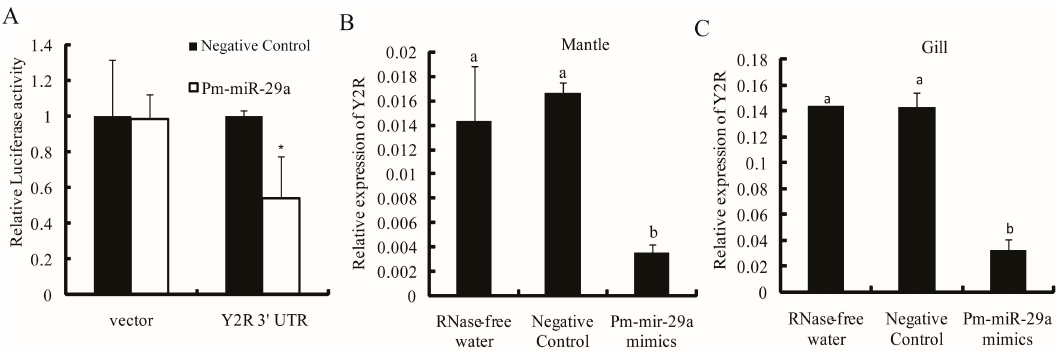
Figure 4. Target verification between Pm-miR-29a and Y2R . ( A ) Pm-miR-29a mimics obviously inhibited the luciferase activity of the 3 ′ UTR of the Y2R gene detected by dual-luciferase analysis. “*” represents a significant difference ( p < 0.05). The relative expression of Y2R in the mantle ( B ) and gill ( C ) were detected by qRT-PCR after Pm-miR-29a mimic injection. GAPDH gene was used as the reference gene. Different letters mean a significant difference ( p < 0.05); error bars correspond to mean ± SD.